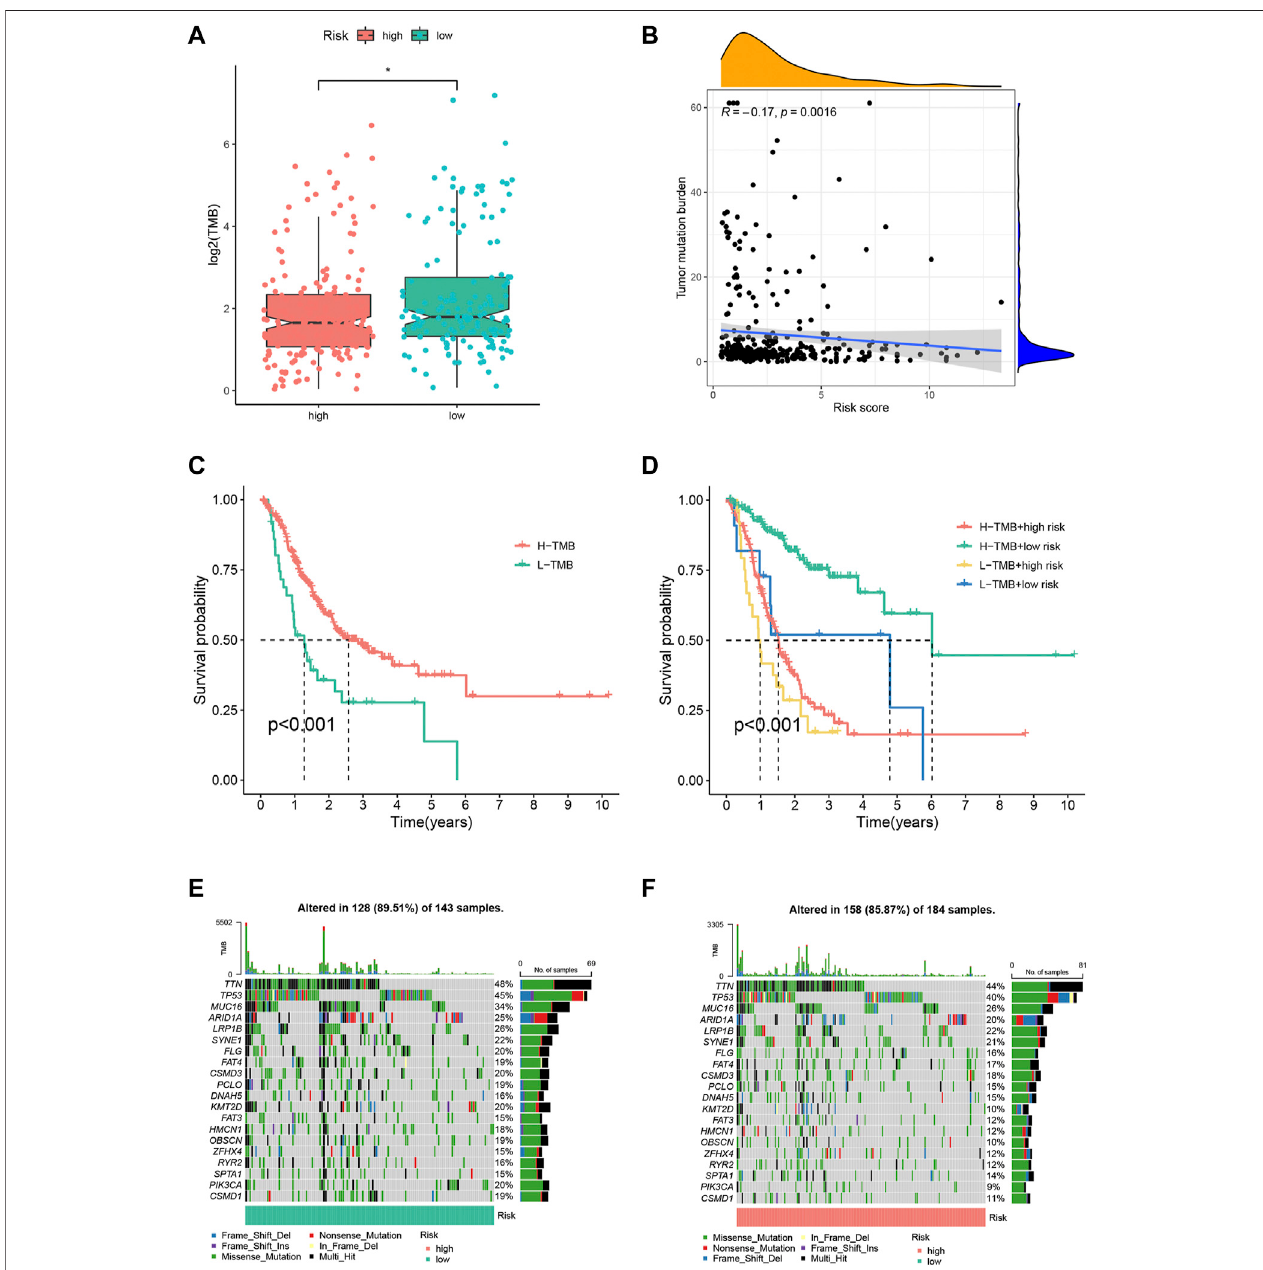
FIGURE 5 | Tumor mutation burden (TMB) analysis of the FRLP risk score model. (A) TMB difference between high- and low-risk groups. (B) Correlation between the risk score and TMB. (C) Kaplan – Meier plots of patients with high and low TMB. (D) Kaplan – Meier curves of patients strati fi ed by both TMB and the risk score. (E,F) Gene mutation analysis of patients in low- and high-risk